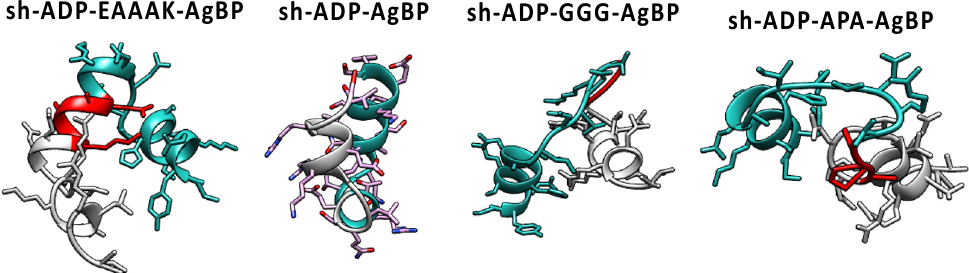
Figure 3. Folding pattern of the bifunctional peptide structures composed of AgBP2 and shADP5 peptide domains linked with different spacer sequences. Estimated magnitude of the folding change is provided in Table 1.